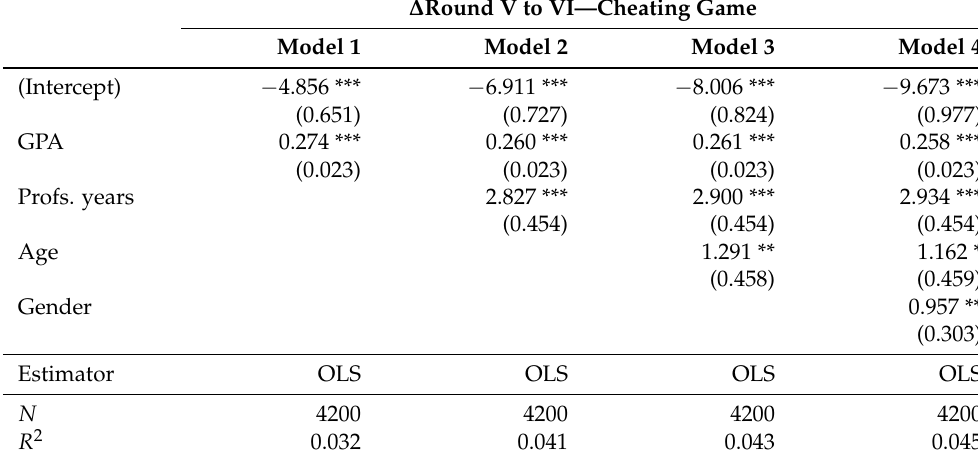
Table A1. Regression model of cheating contest game. ∆ Round V to VI—Cheating